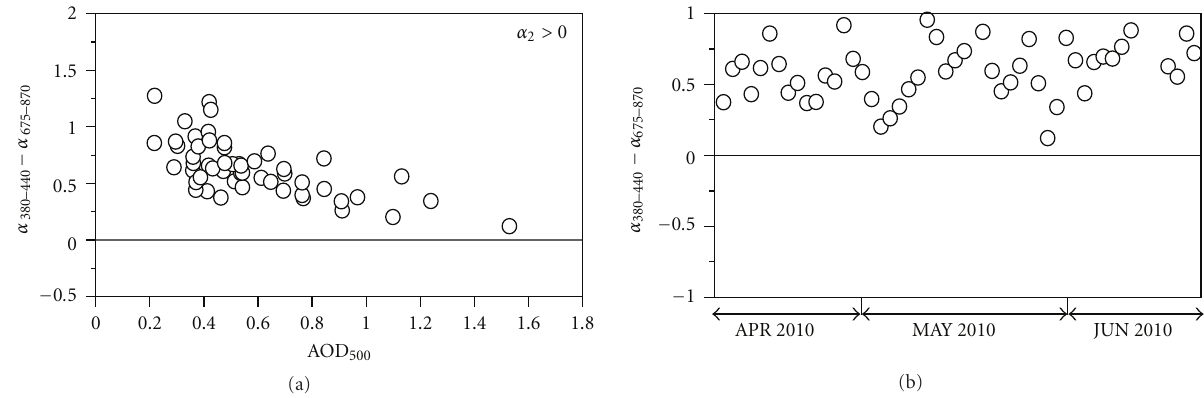
Figure 7: Scatter plot of α 380 − 440 – α 675 − 870 versus AOD 500 (a), and day-to-day variation of the di ff erence α 380 − 440 – α 675 − 870 during the premon- soon season of 2010 (b).